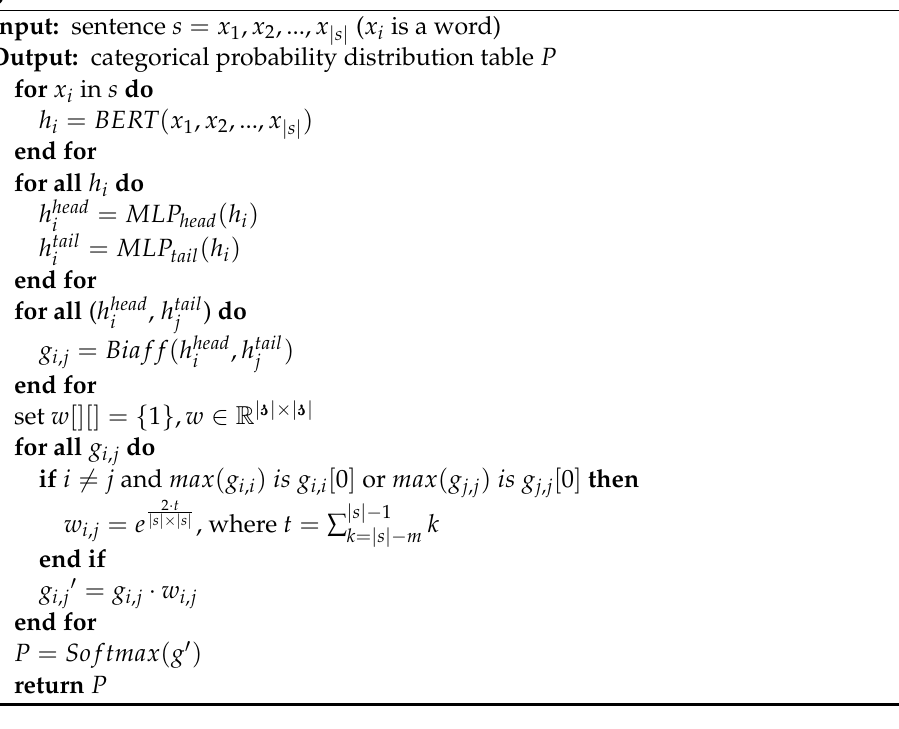
Avg ( P i : j , m : n , r ) . If r (cid:48) ∈ (cid:76) r , the relation lies on the entity pair; table is r (cid:48) = argmax r ∈ (cid:76) r ∪ null otherwise, no relation exists. The decoder is as Algorithm 2. Algorithm 1: